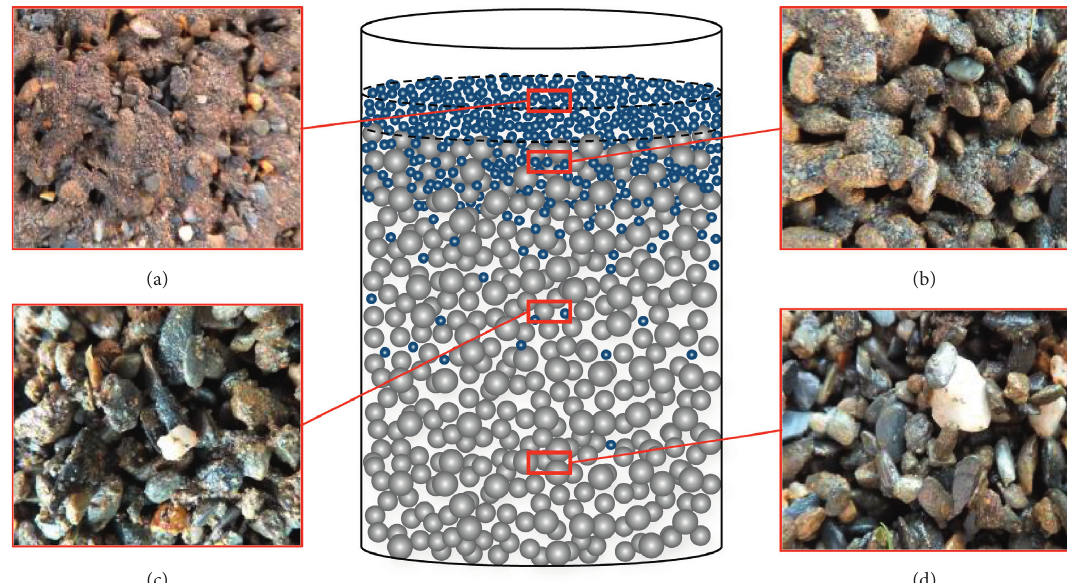
Figure 4: Images of soil media at different layers after experiment and soil media particles of size in 2–4mm using USB DIGITAL MICROSCOPE. (a) Surface of the soil media. (b) Surface of layer 2. (c) Surface of layer 3. (d) Surface of layer